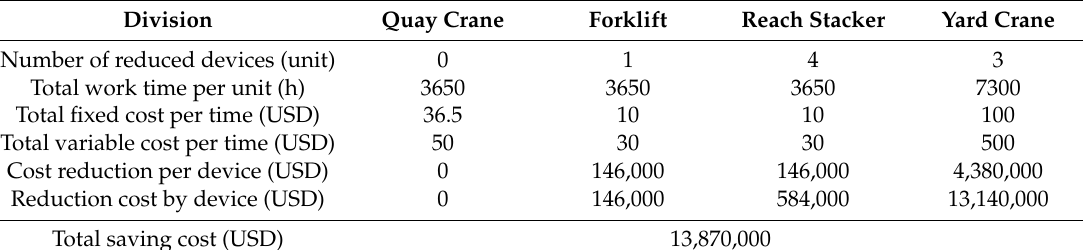
Figure 5. Correlation between container throughput and operating costs (quay crane). Table 6. Cost of reducing operational equipment for the port-container